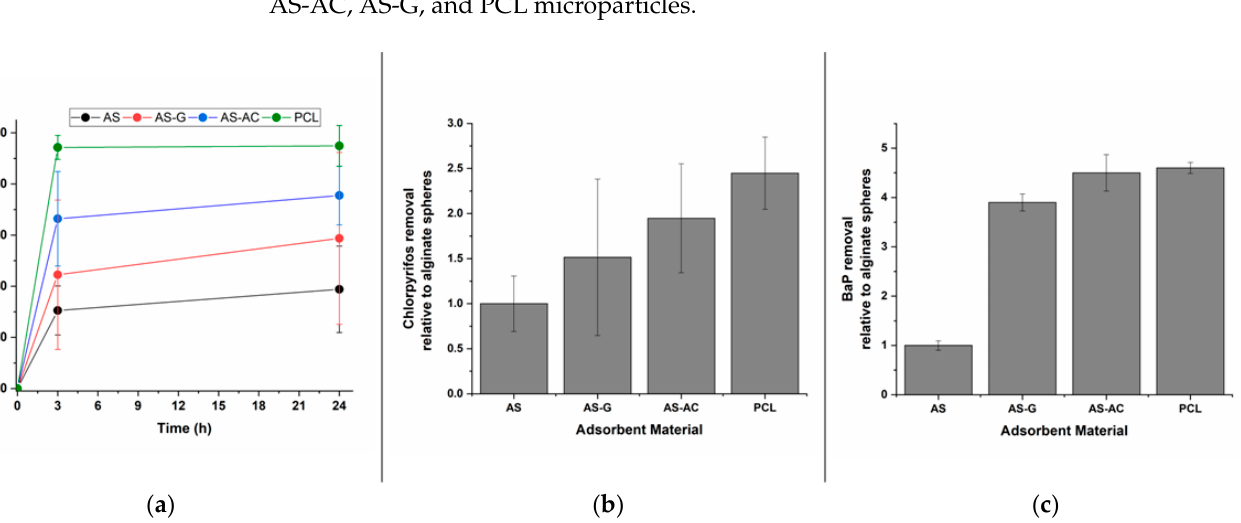
Figure 2. Representative images of polycaprolactone (PCL) microparticles. ( a ) Photograph of PCL microparticle powder visible to the naked eye, and ( b ) micrograph of a PCL microparticle using phase contrast. The diameter of PCL microparticles was 30 ± 12 μ m (n = 27). Micrograph obtained using a Nikon Coolpix 995 camera coupled to a Nikon Eclipse E200 microscope.